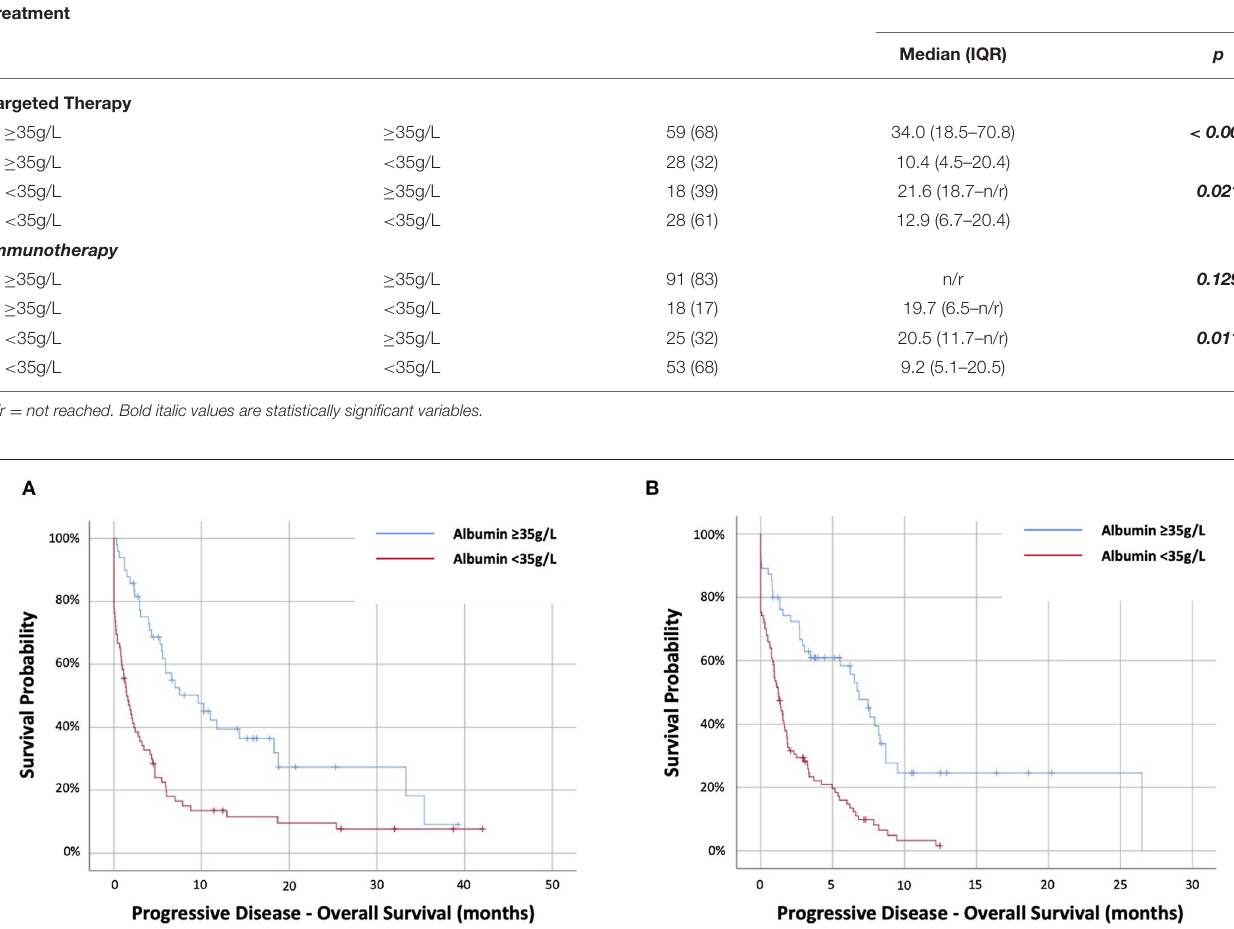
TABLE 3 | The relationship between dynamic change in albumin between pre-treatment and 12 weeks and overall survival in patients with NSCLC treated with first-line targeted therapy or immunotherapy-based therapy: univariate log-rank analysis. Albumin—Pre- Treatment